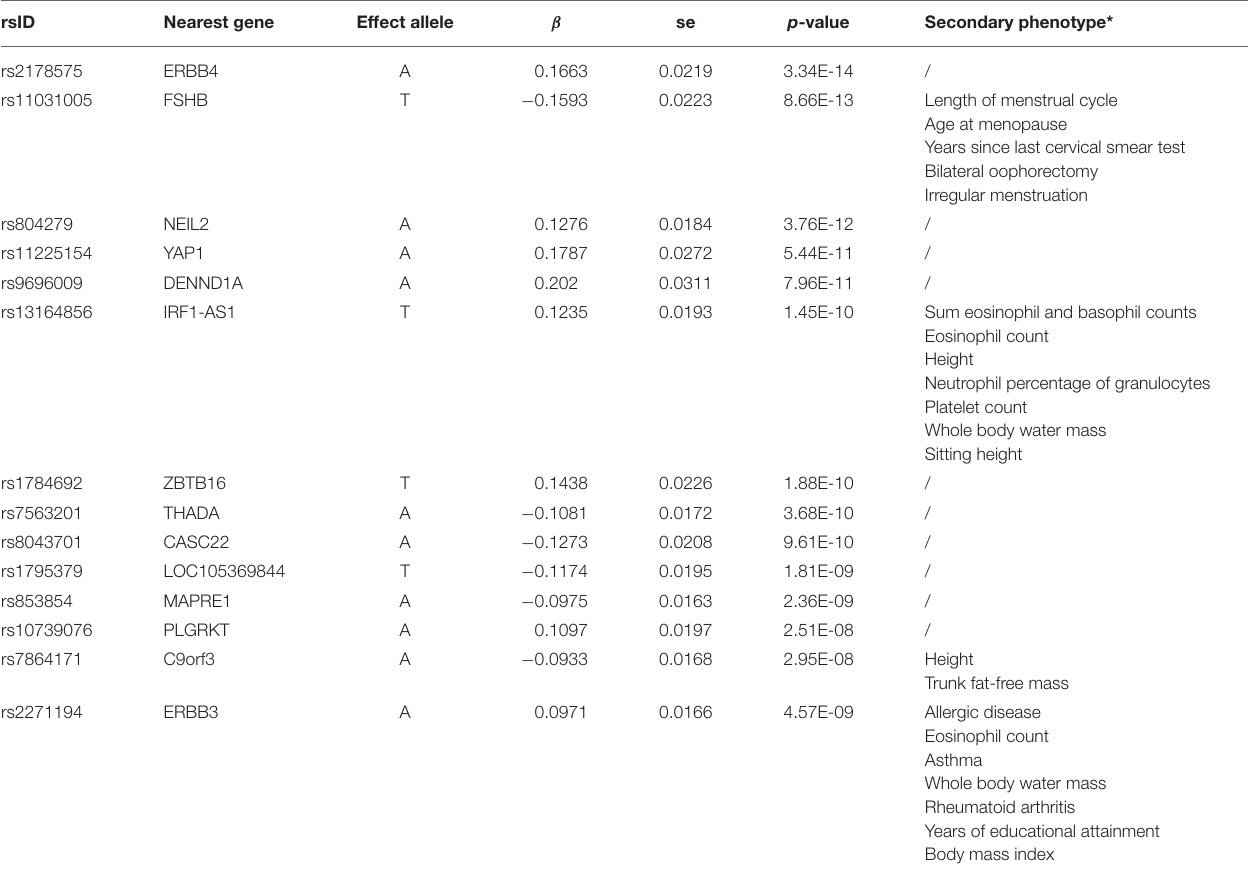
TABLE 3 | The 14 single-nucleotide polymorphisms (SNPs) used as instrumental variables (IVs) of polycystic ovary syndrome.